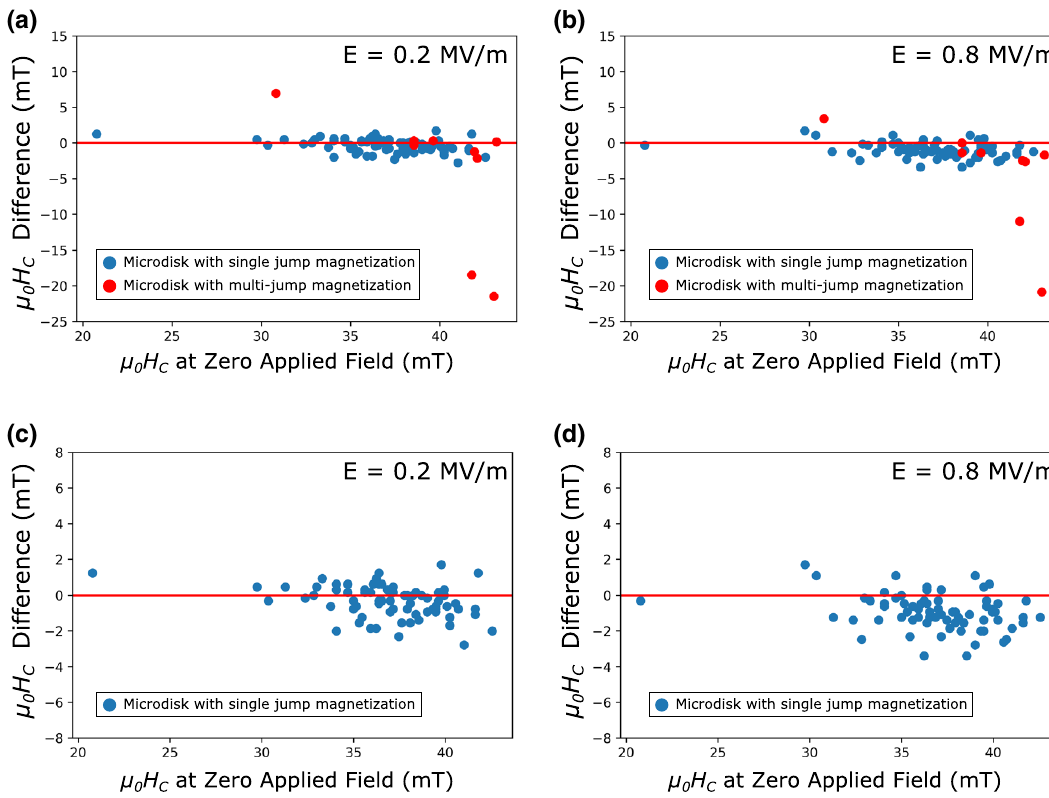
Figure 5. Scatter plots of μ 0 H C at zero applied E-field versus the μ 0 H C difference under the applied electric fields ( a ) between 0 and 0.2 MV/m ( b ) between 0 and 0.8 MV/m. ( c ) and ( d ) represent the microdisks with a single μ 0 H C value in ( a ) and ( b ),